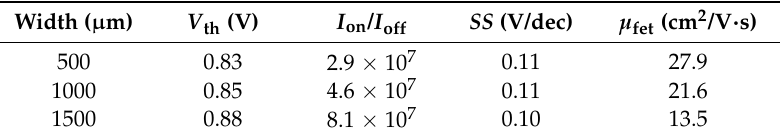
Table 1. The performance parameters of a -IGZO TFTs with SiO 2 gate dielectric. Width ( µ m)